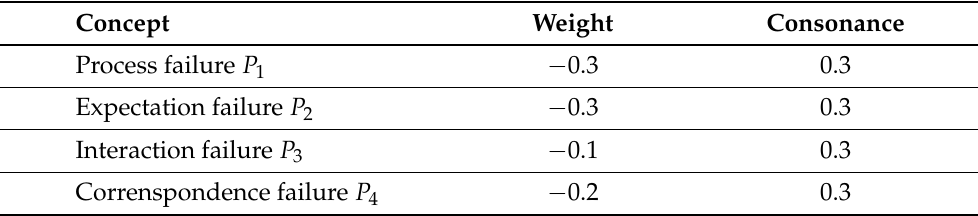
Table 10. Targeted concept changes in the fuzzy cognitive map determining the failure of the banking project.